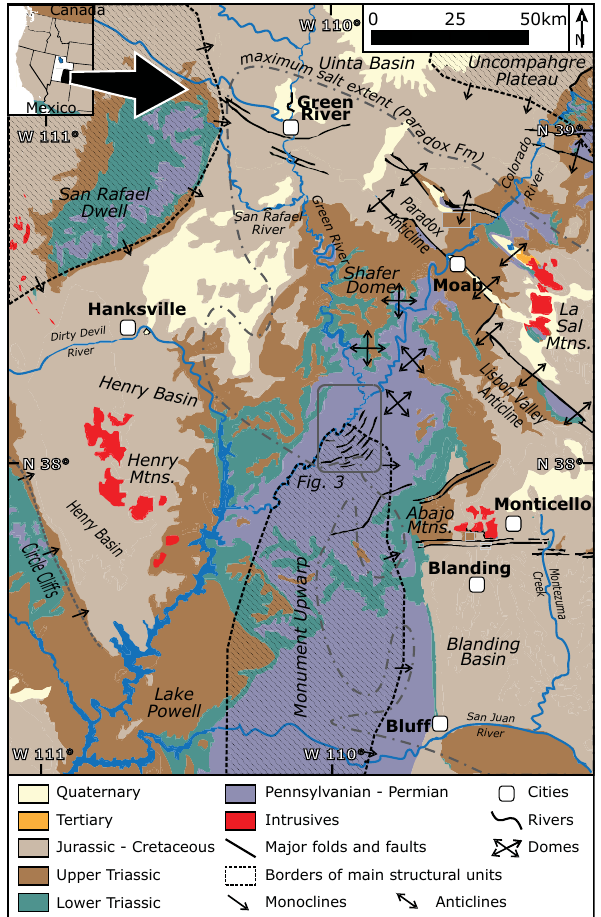
Figure 2. Geology of SE Utah and major structural units. Inlet in- dicates location of Fig. 3. The study area (grabens in the Canyon- land National Park) is located at the northern end of the Monument Upward, east of the Colorado River. Geological and structural data compiled from Huntoon et al. (1982), Condon (1997), Hintze et al. (2000) and Gutiérrez